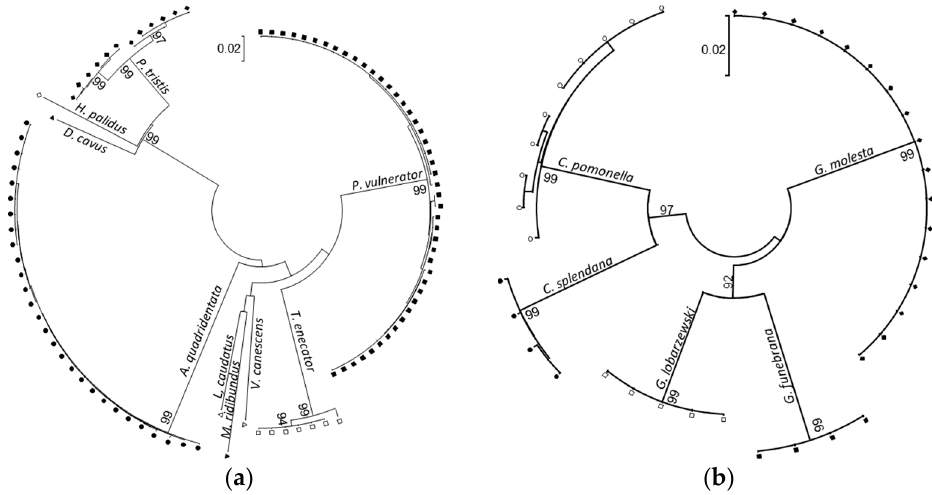
Figure 1. Neighbor-Joining trees (Saitou and Nei 1987 [36]) of ( a ) the codling moth Hymenoptera parasitoids (97 specimens, nine different genera) and ( b ) of their potential tortricid hosts (40 specimens, five different species). The evolutionary distances between coding sequences (651 positions) were computed using the Kimura two-parameter method (Kimura 1980 [37]). The confidence probabilities that the interior branch length is greater than zero (Dopazo 1994 [38]) were estimated using bootstrap tests (2000 replicates) and were represented next to the branches for a probability above 90%.